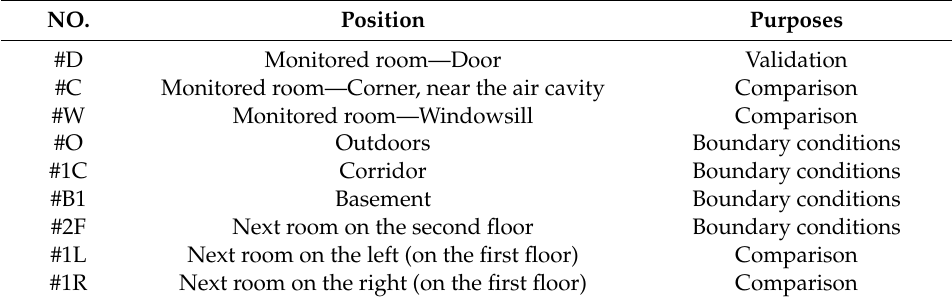
Figure 5. The thermocouples in the monitored room measuring the surface temperature. Table 1. Positions and purposes of hygrothermometers.